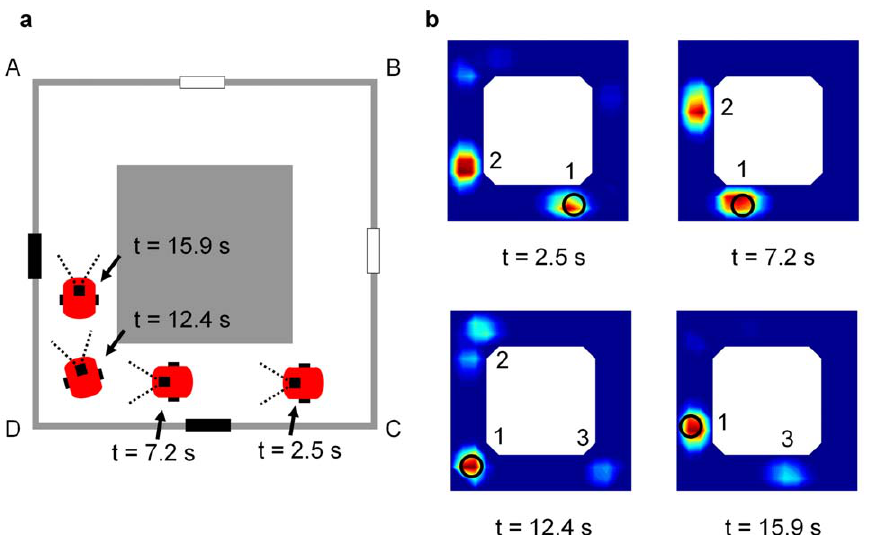
Figure 10. The actual robot pose and corresponding location estimates encoded by the ensemble cell firing. Each firing plot corresponds to various times after the robot was replaced at corner C facing D. (a) Schematic of the robot’s pose corresponding to each of the four ensemble firing plots. (b) Location estimates as encoded by the weighted sum of the firing fields of all active cells at various times. The circle shows the robot’s actual location. Cell firing initially (t=2.5, 7.2 s) supported and maintained two approximately equal location estimates (1 and 2) – sighting the first black cue did not provide sufficient information to disambiguate the robot’s location. After sighting of the second black cue (t=12.4 s), cell firing resolved to code primarily for the correct location 1 – location estimate 2 disappeared (t=15.9 s) and there was limited firing for a new location estimate 3. Figure 12 provides a schematic explanation of the ensemble cell firing.